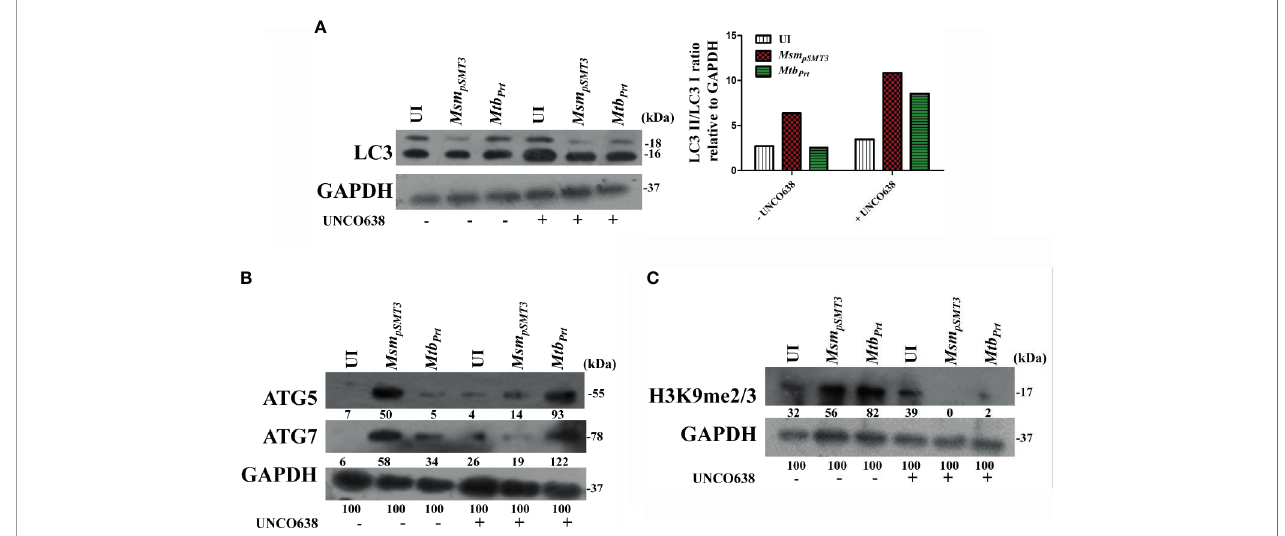
FIGURE 5 | Expression of histone hypermethylation and autophagy in bone marrow derived macrophages infected with Msm pSMT3 and Mtb Prt . Bone marrow derived macrophages were infected with Msm pSMT3 and Mtb Prt strains followed by treatment with UNCO638 (G9a inhibitor) for 24 h. Western blot analysis was performed to check the (A) conversion of LC3I to II (Densitometry is representative to the particular western blot data), and expression of (B) ATG5 and ATG7, and (C) H3K9me2/3. The experiments were performed in triplicate (n=3). Msm pSMT3- Msm harbouring pSMT3 plasmid; Mtb Prt - recombinant Msm expressing MtbPrt (Rv3242c) .